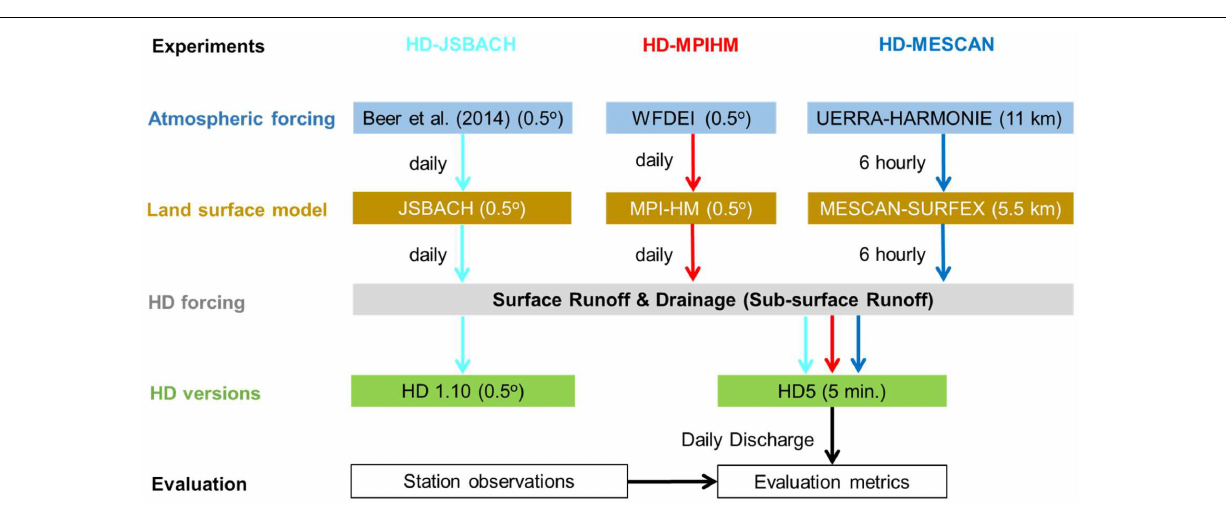
FIGURE 3 | Flowchart showing the main steps of generating simulated discharges with the HD model and conducting their evaluation in the present